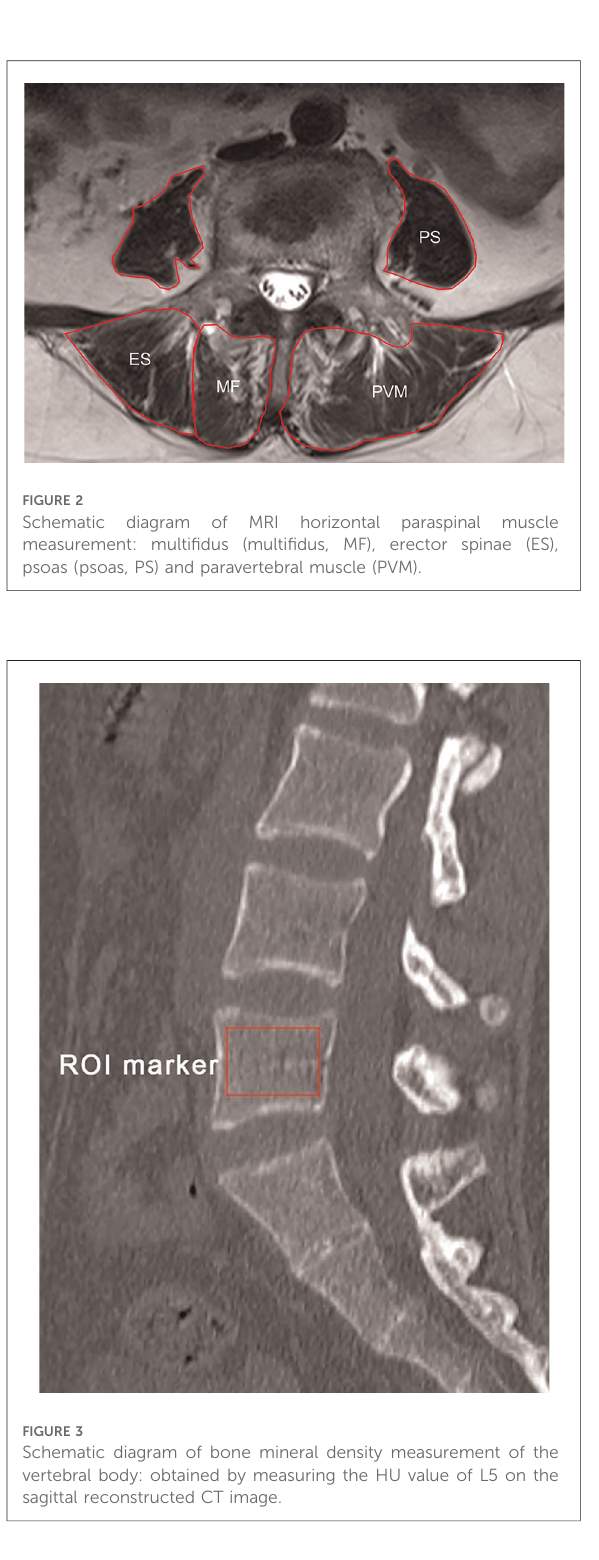
images ( Figure 3 ) (16). Parameters related to the fractured vertebra were measured on radiography, including preoperative kyphotic angle (KA), preoperative anterior-to- posterior body height ratio (AP ratio), anterior vertebral